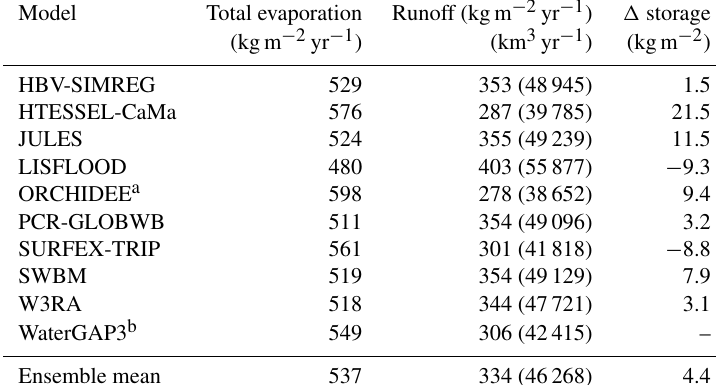
Table 7. Mean evaporation and runoff for the whole period compared to the change in storage of the total moisture component of each model. Mean precipitation for the whole period using the common land surface mask was 863 (kgm − 2 yr − 1 ). Surface water storage and storage in snow and glaciers is not taken into account. A positive change in storage indicates the model lost water storage during the simulation period.